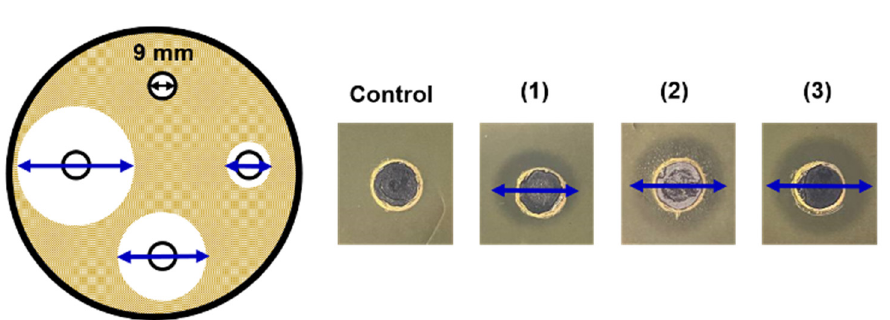
Figure 15. The scheme of the agar well diffusion method. The inhibition zones on Petri dishes appeared after treatment of (1) 2b 5 μ g/mL; (2) 2b 7 μ g/mL; (3) HP β CD- 2b 10 μ g/mL; pH 7.4 (0.01 M sodium phosphate buffer), 37 °C, 24 h of incubation. Blue arrows demonstrate the diameter of the inhibition zone. Table 3. The MIC values of different samples, pH 7.4 (0.01M PBS), 37 ° C. MIC, μ g/mL